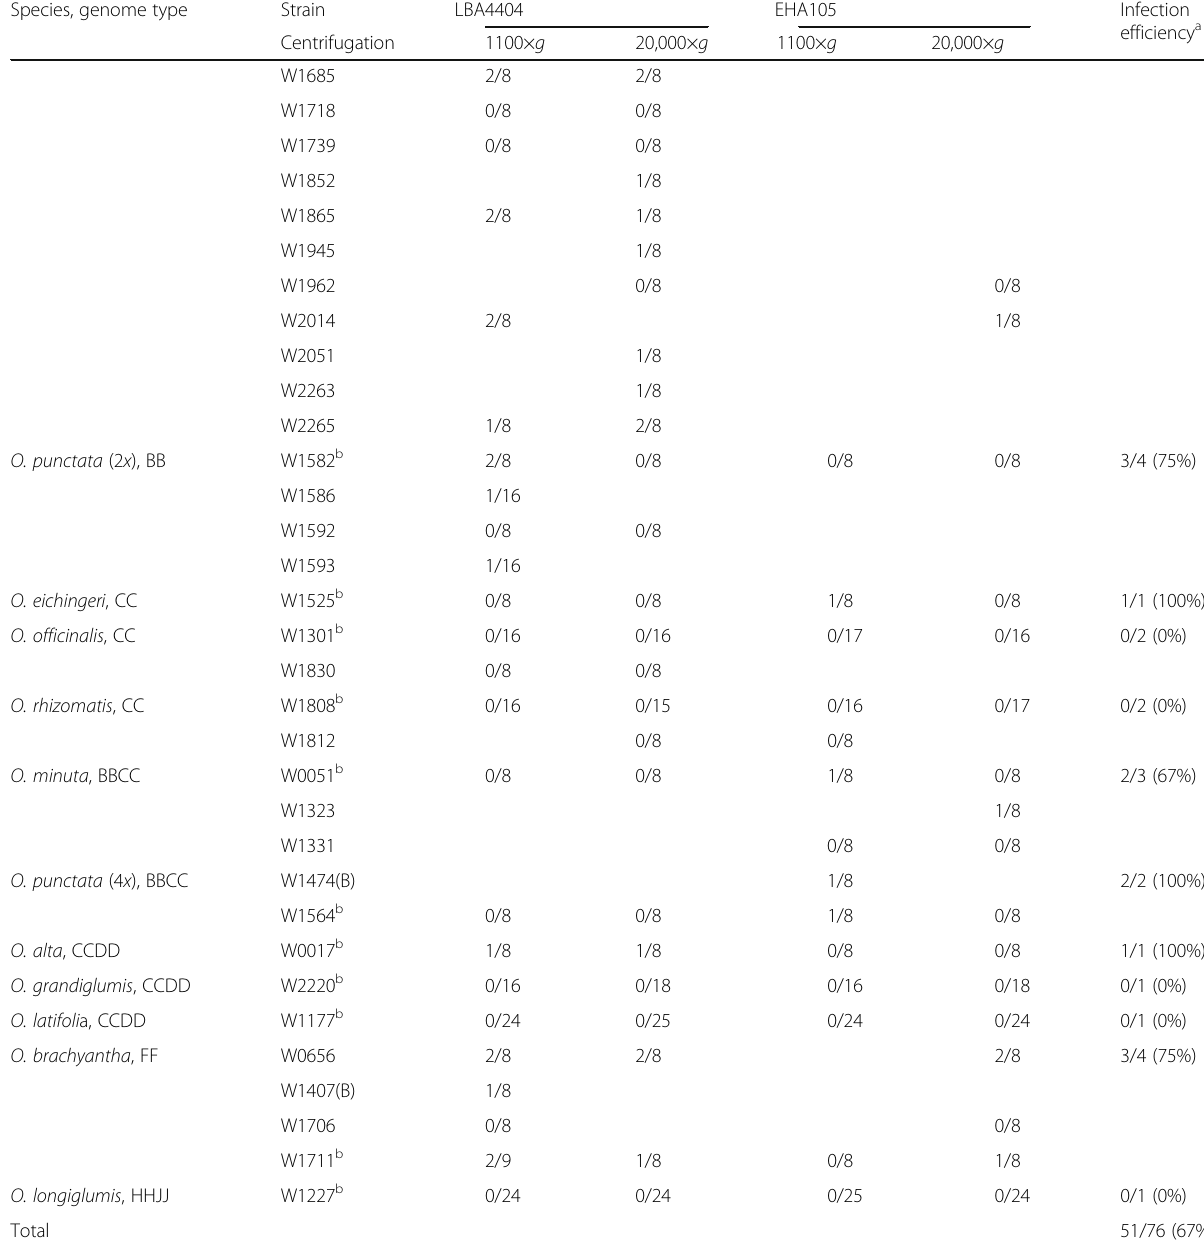
Table 5 Efficiency of Agrobacterium infection of calli induced from immature embryos of 76 accessions of wild Oryza (Continued) Species, genome